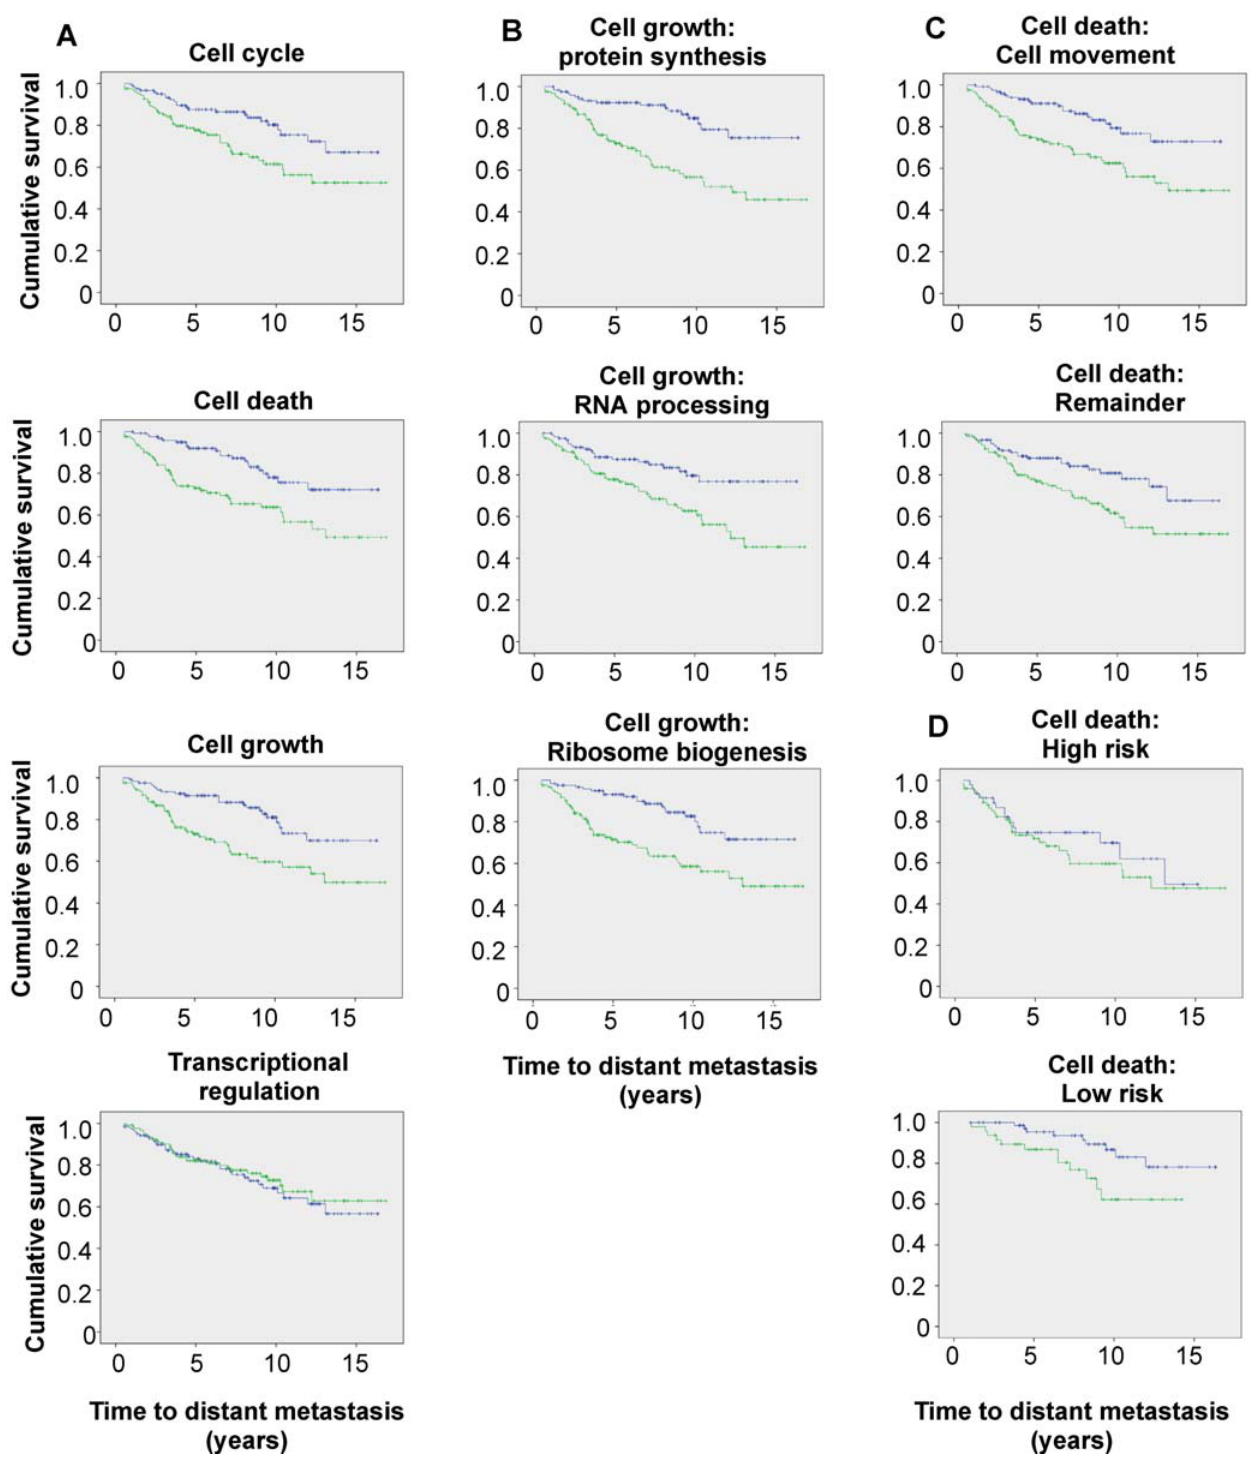
Figure 7. Relationship between estrogen-regulated gene signatures and response to tamoxifen therapy. Kaplan-Meier survival curves of the relationship between time to distant metastasis and the indicated gene signatures, dichotomised at the 50th percentile, in a cohort of 246 breast cancer patients treated with tamoxifen. (A) Signatures illustrated in Fig. 5. (B) Subsets of the ‘cell growth’ signature. (C) Subsets of the ‘cell death’ signature. (D) Patients were sequentially stratified using the ‘cell death’ and ‘cell cycle’ signatures. doi:10.1371/journal.pone.0002987.g007 which inhibits DNA synthesis but not growth [35], and the known Like the ‘cell cycle’ network, the ‘cell death’ network contains both role of c-Myc in regulating cell growth in mammalian cells effectors and upstream regulators. Bcl-2 acts as a hub connecting [24,36]. many of the effectors, consistent with the well-documented role of